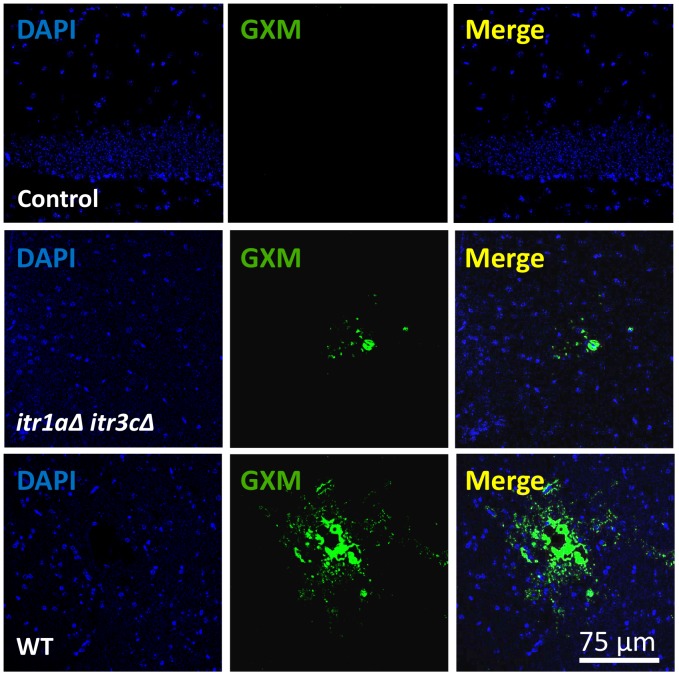

Cryptococcus cells penetrate into the brain by a mechanism involving fungal inositol transporters.Confocal analyses were performed using tissue sections obtained from mice that were either uninfected, or infected with wild type H99 (WT) or the itr1aΔ itr3cΔ mutant for 48 hr. Lesions were identified by the high accumulation of GXM within the CNS parenchyma (Cn, green channel) and DAPI staining (blue channel) to observe the nuclei in the cells. Animal brains infected with the mutant have less and smaller lesions. Bar indicates 75 µm.